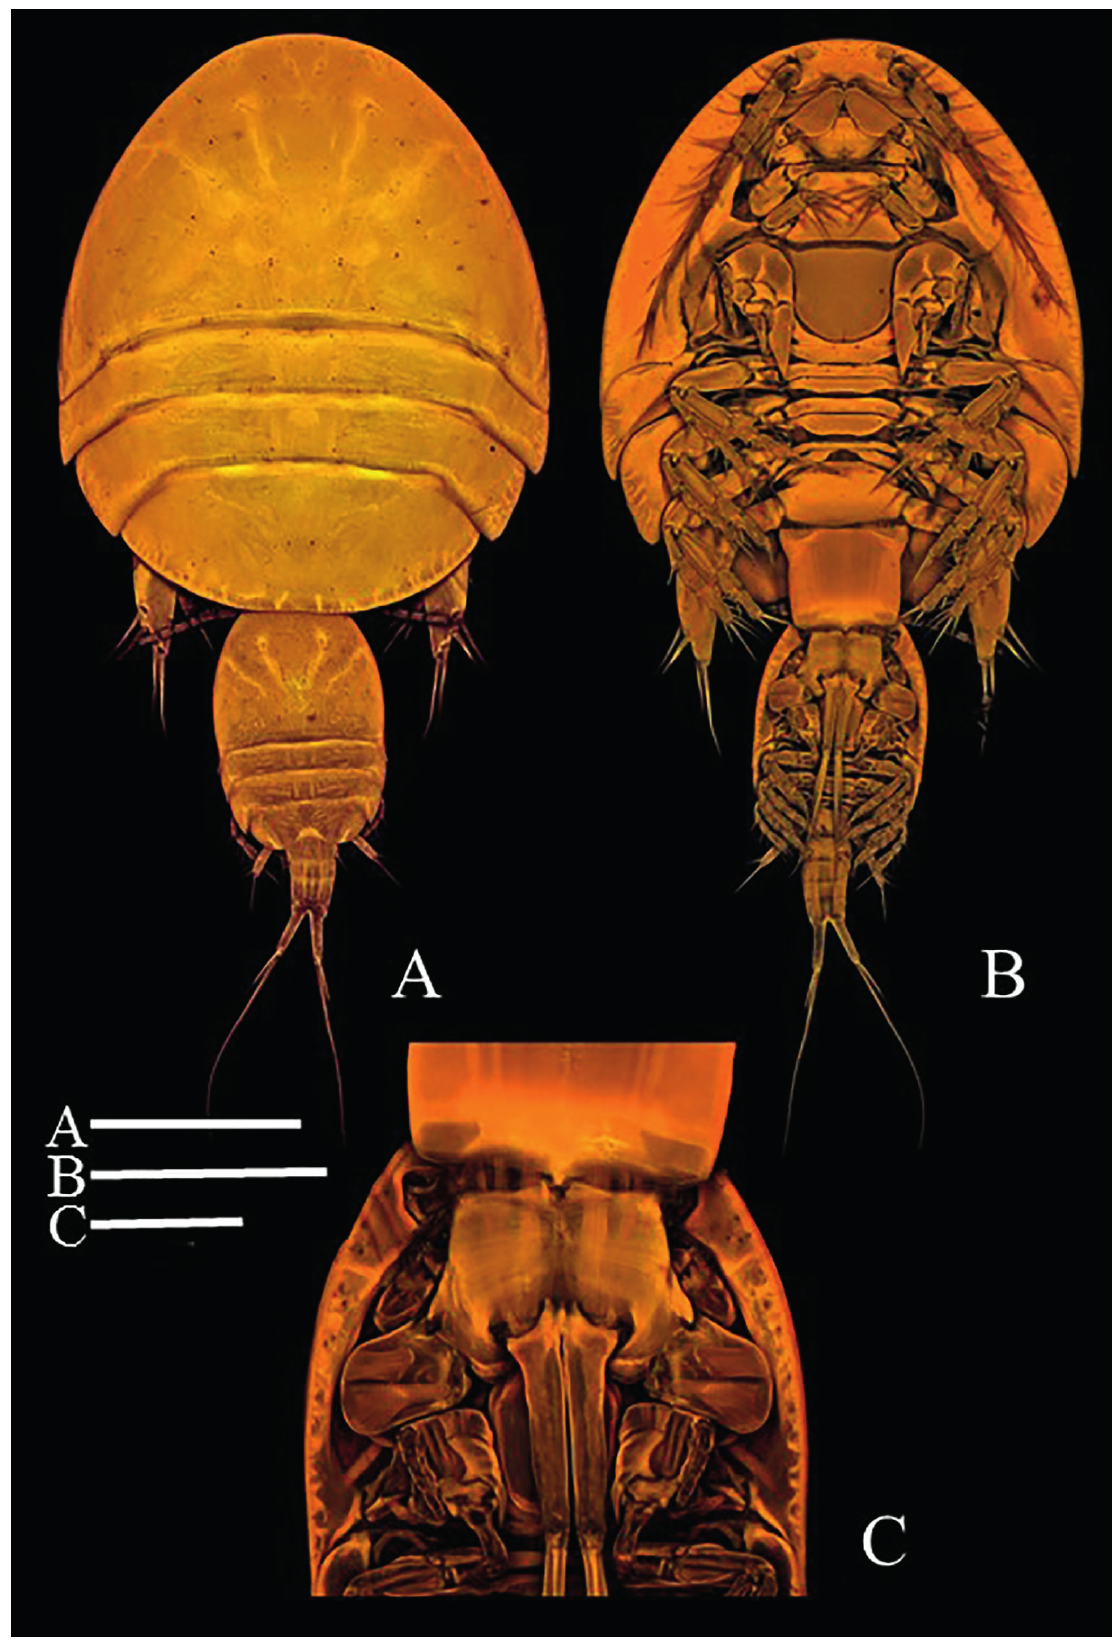
Figure 11. Clausidium persiaensis sp. nov. (couple). Confocal laser scanning microscopy images. A, habitus, dorsal; B, habitus, ventral; C, male grasping female with maxilliped. Scale bars: A, B, 200 μm; C, 50